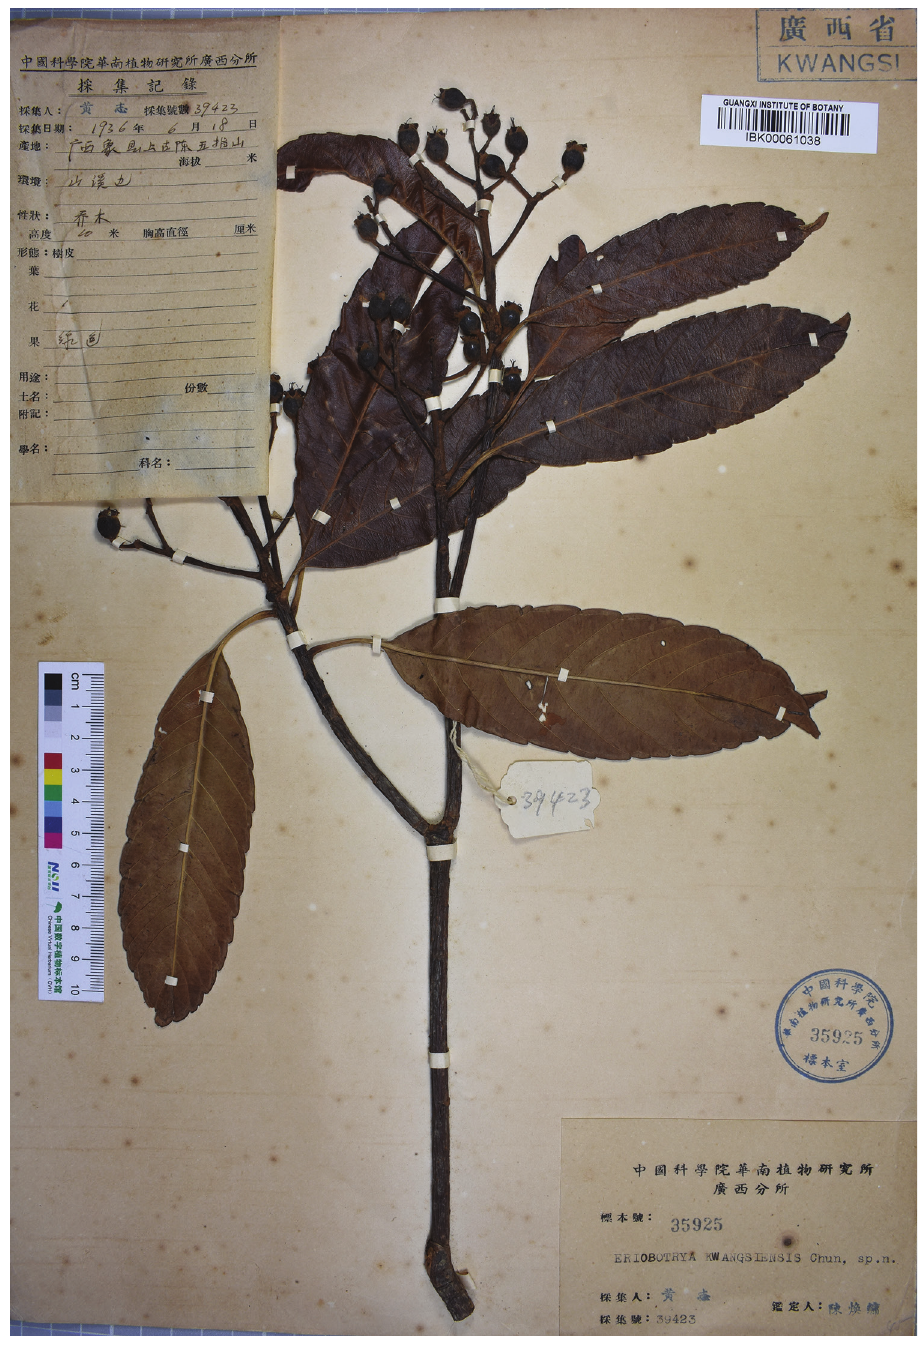
Figure 2. Holotype of Rhaphiolepis yui (IBK [barcode